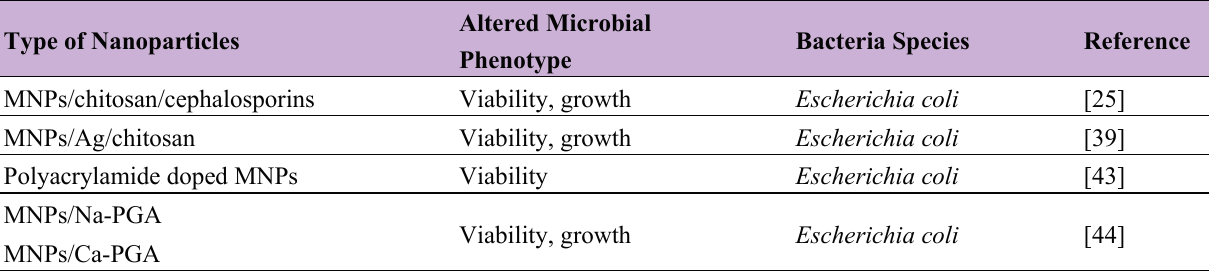
Table 4. List of plain and functionalized MNPs derivatives with effect on several microbial